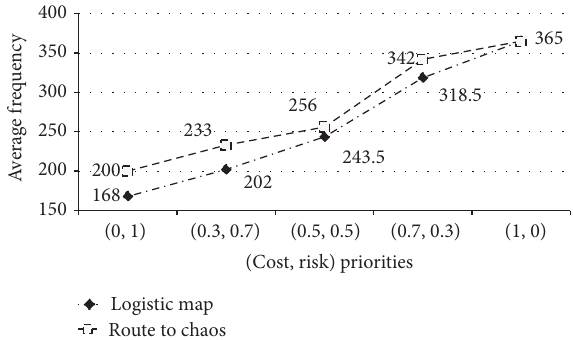
Figure 3: Average path frequency using methods of generating cha- otic